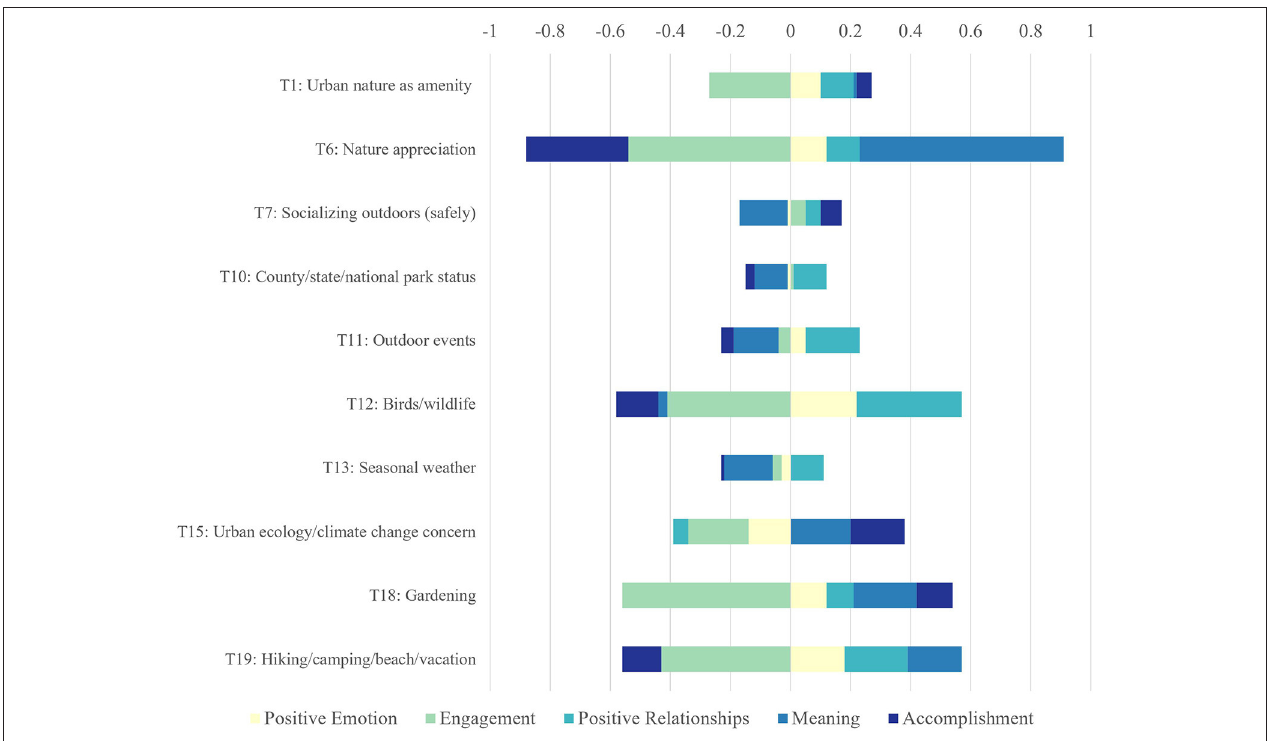
FIGURE 4 | β coefficients of topics as compared with overall PERMA index and individual subfactors in Twitter dataset, January to July